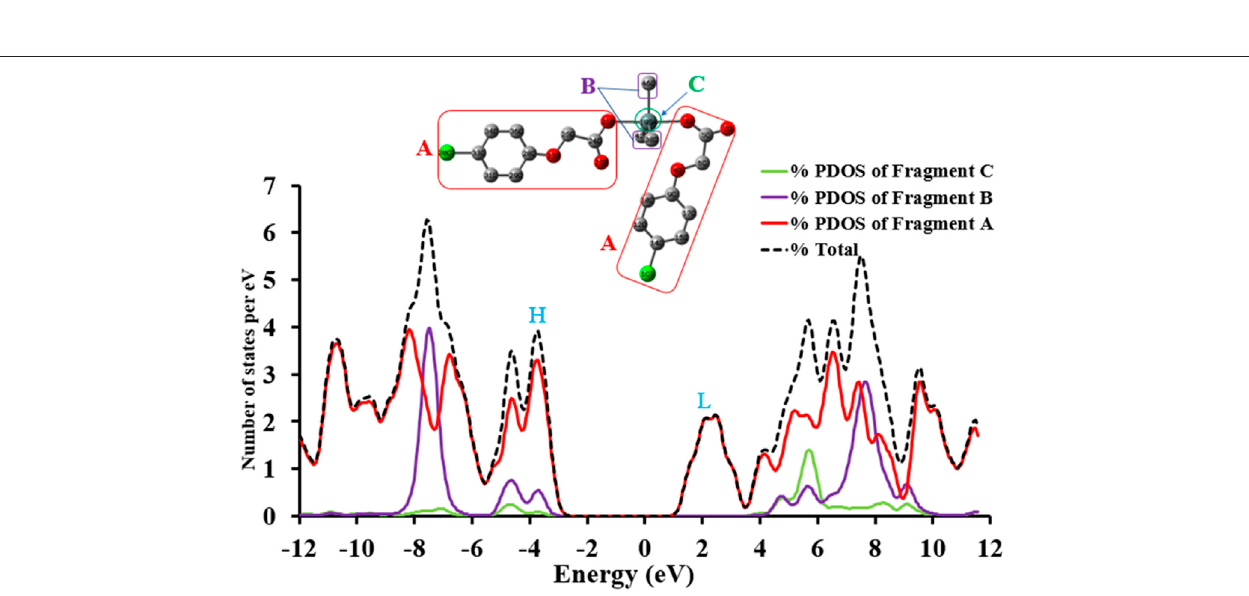
FIGURE 3 | The TDOS and PDOS of complex 4 at B3LYP/6-31G* + LANL2DZ level of theory, where H and L illustrate the energy regions of HOMO and LUMO, respectively.